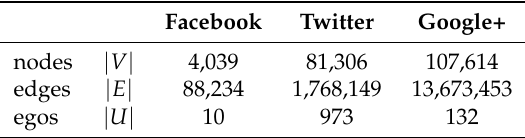
Table 1. Statistics of social network